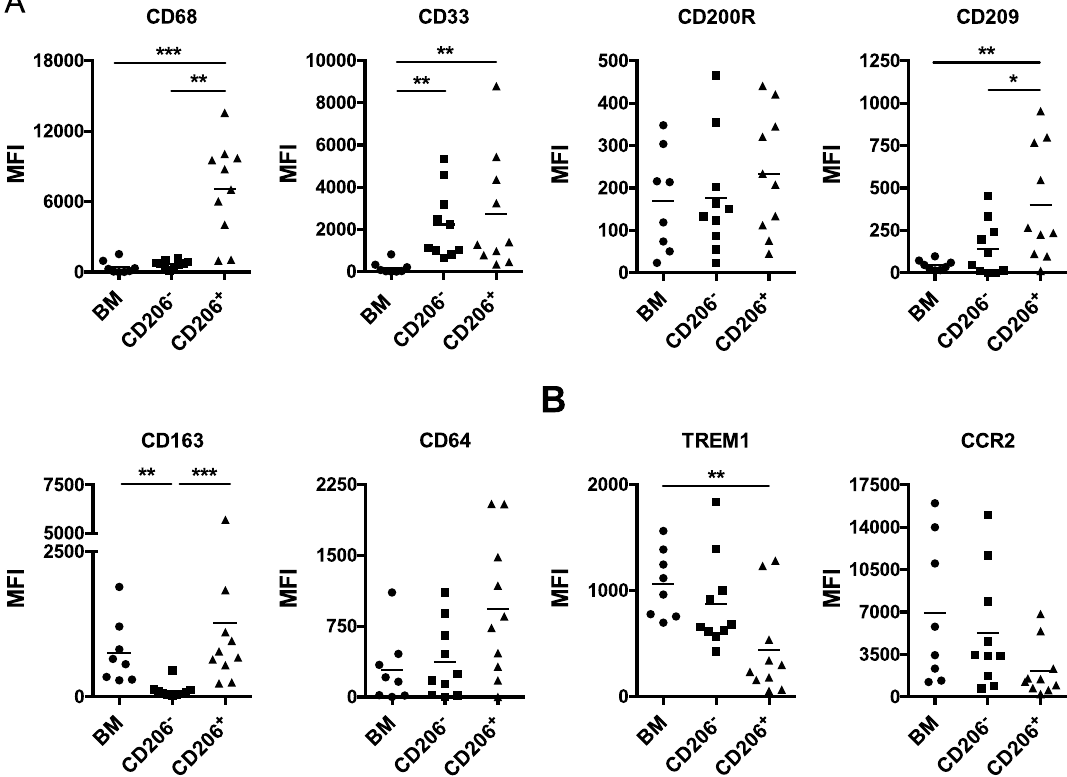
Figure 2. Phenotypic characterisation of CD64 + CD206 − and CD64 + CD206 + healthy colonic macrophages, and healthy blood monocytes (BM) by flow cytometry. ( A ) Expression of macrophage associated cell surface markers. ( B ) Protein expression of monocyte associated cell surface markers; n = 8, 10 and 10 for BM, CD206 − and CD206 + , respectively.